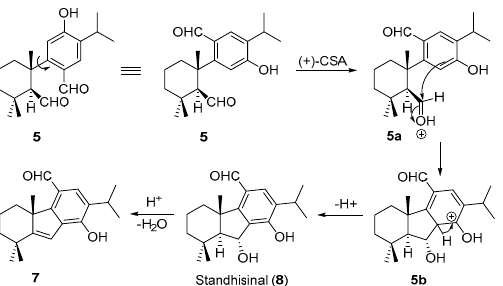
A possible mechanism is shown in Scheme 3. The cyclopentane ring is formed after the attack of the aliphatic aldehyde enol on the aromatic aldehyde. The dehydration of the protonated resulting aldol ( I ) leads to benzylic cation II , which is finally converted into the tricyclic cyclopentene derivative 6 after losing formic acid.